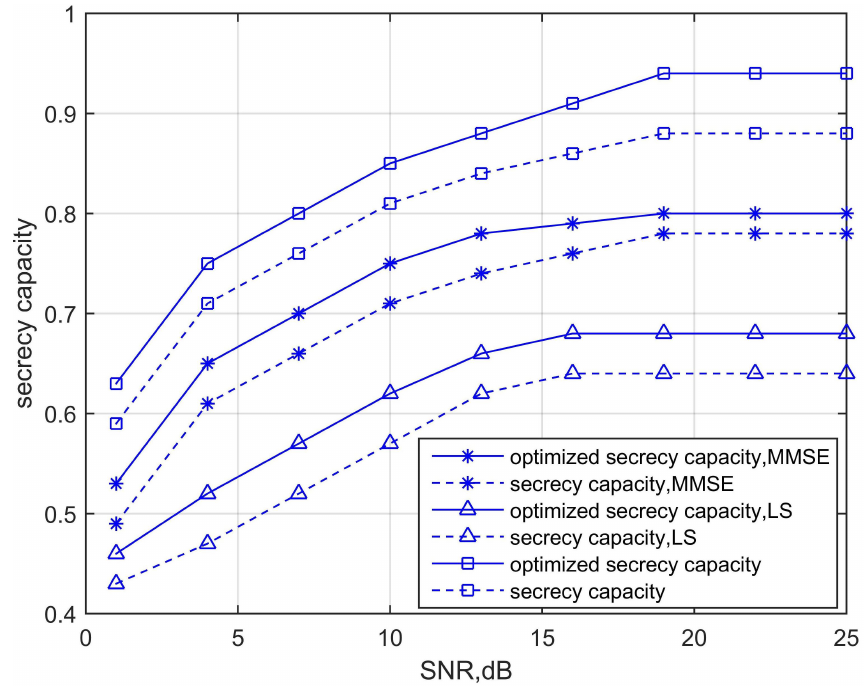
Figure 5. SCO − AN’s Secrecy Capacity Before and After Power Allocation versus Different SNR and Channel Estimation